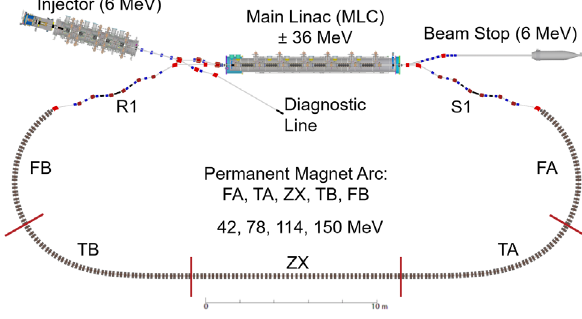
FIG. 1. Layout of CBETA in the one-turn